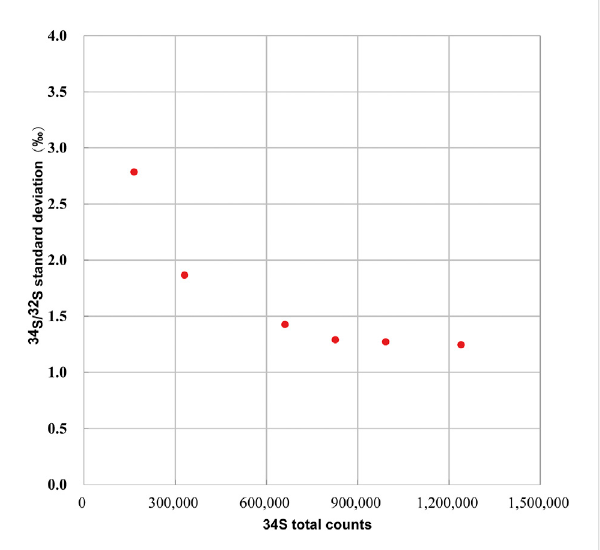
FIGURE 7 The relationship between internal precision, Poisson error, and 34 S total counts.